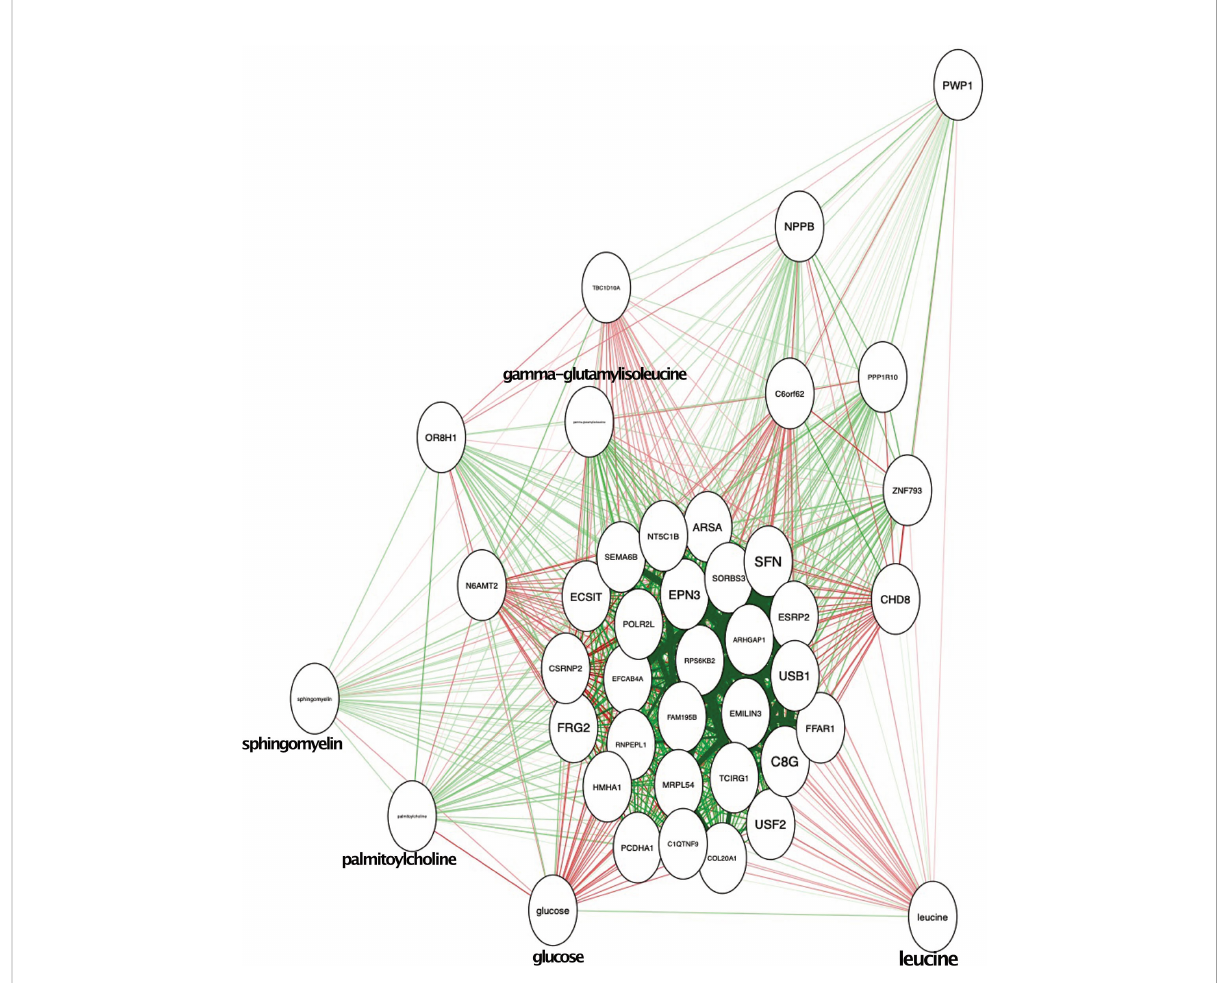
FIGURE 5 Integration of metabolic and epigenomic data. The red lines indicate the positive correlation and green lines indicate the negative correlation. The fi ve metabolites and the genes are shown in the